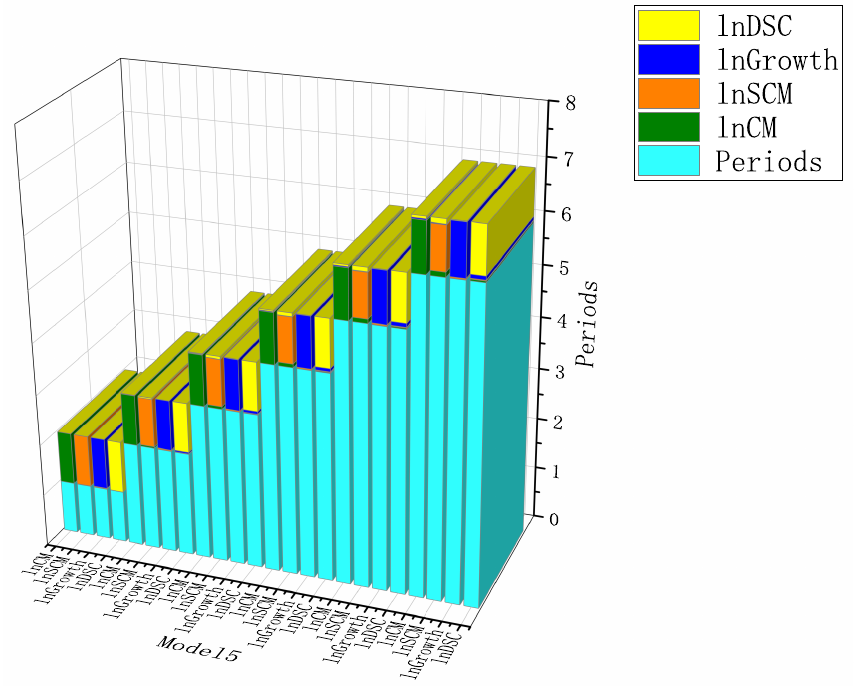
Figure 16. The graph shows the results of the variance decomposition of Model 5. The horizontal axis indicates the different variables including debt servicing capacity (lnDSC) (in yellow), growth capacity (lnGrowth) (in blue), supply chain management (lnSCM) (in orange), and corporate management (lnCM) (in green); the vertical axis indicates the contribution of each variable at different lags (see Appendix A for specific figures), and the light blue area indicates the number of periods